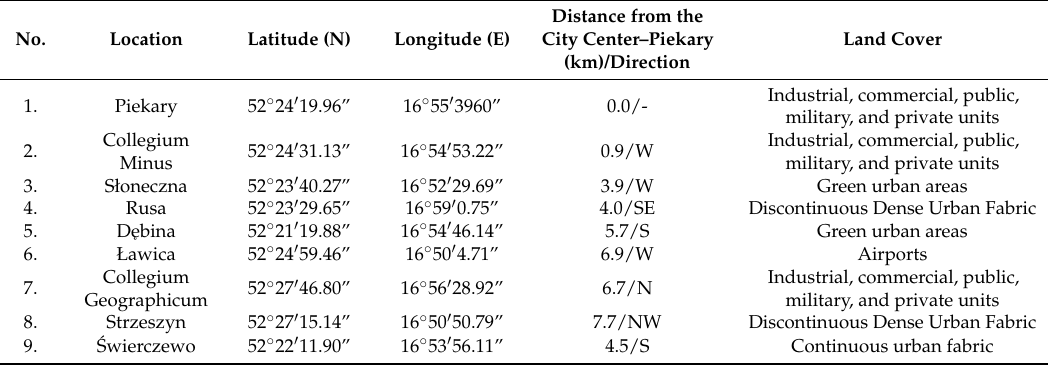
Table 1. Location and characteristics of measurement points in